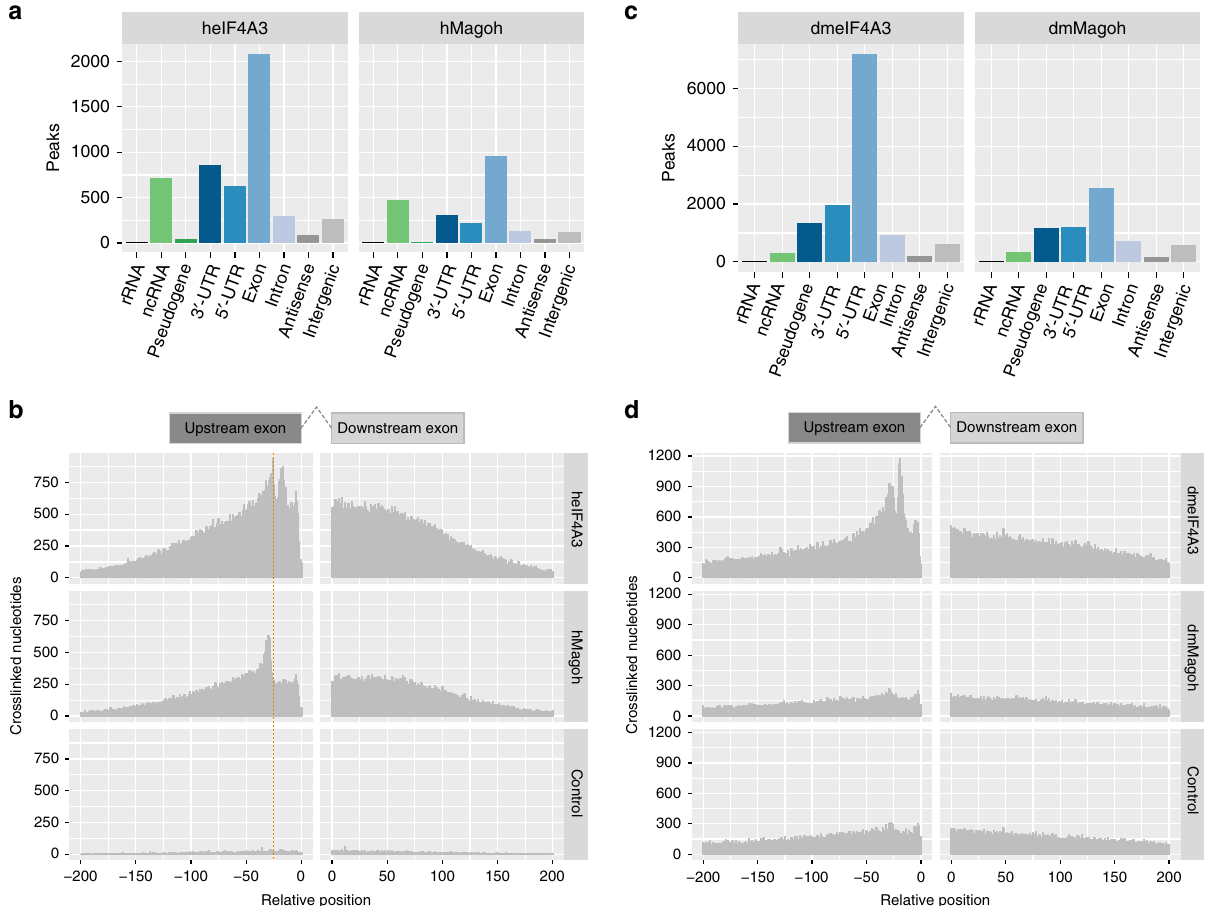
Fig. 4 EIF4A3 binds upstream of exon – exon junctions. a Number of JAMM peaks located on genomic target classes for human EIF4A3 and MAGOH. Priority of target classes as in Fig. 3. b Histogram of crosslinked nucleotide positions for human EIF4A3, MAGOH and the corresponding control. EIF4A3 and MAGOH show increased binding 20 – 30 nucleotides upstream of exon – exon junctions, binding decreased with increasing distance to exon – exon junctions whereas the control is uniformly distributed. c Number of JAMM peaks located on genomic target classes for Drosophila EIF4A3 and MAGOH. Priority of target classes as in Fig. 3. d Histogram of crosslinked nucleotide positions for Drosophila EIF4A3, MAGOH and the corresponding control. EIF4A3 shows increased binding 20 – 30 nucleotides upstream of exon – exon junctions whereas crosslinked nucleotides of MAGOH and the control are